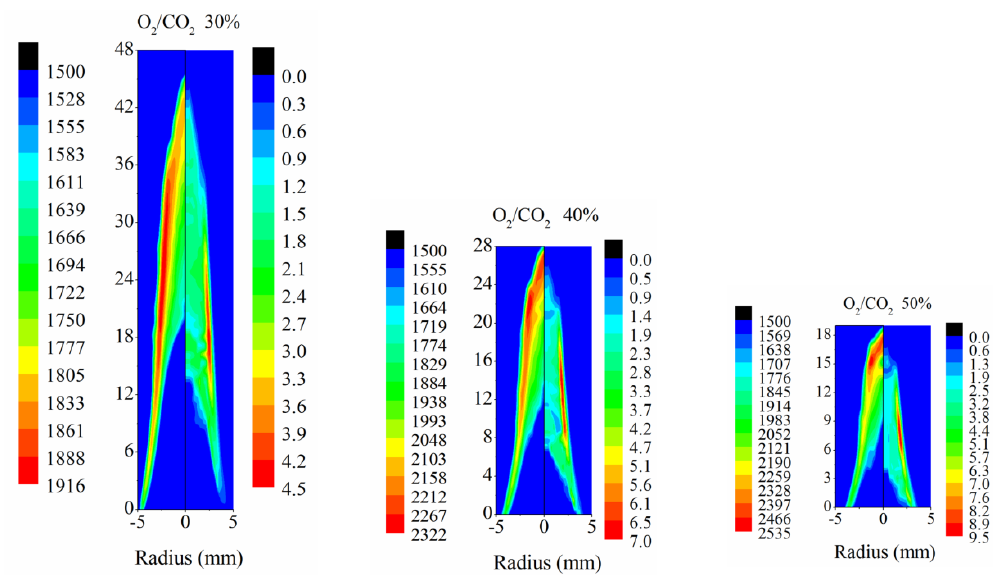
Figure 17. 2-D distributions of temperature T (K) and soot volume fraction (10 − 6 ) for C 2 H 4 combustion in O 2 /CO 2 oxygen-enhanced atmospheres.